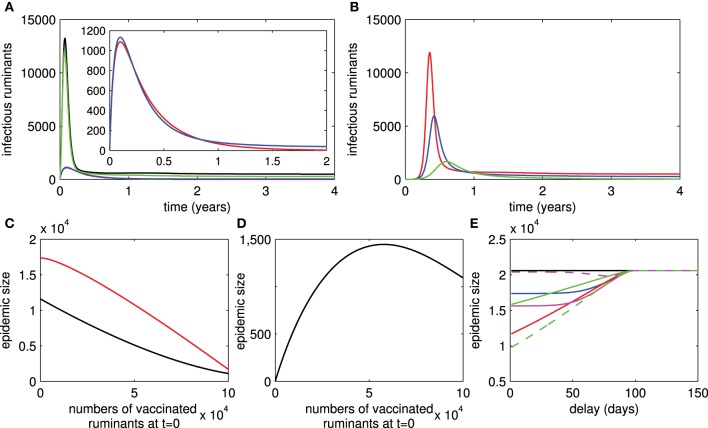
Live and killed vaccines. Infectious numbers of ruminants over time in case of live vaccines are shown in (A) (black trace = with no vaccination and R0 > 1, green trace = with vaccination and R0 > 1, blue trace = with vaccination and R0 < 1, red trace = with no vaccination and R0 < 1). Infectious numbers in case of killed vaccines are shown in (B) (red trace = with no vaccination and R0k>1, blue trace = with vaccination and R0k>1, green trace = with vaccination and R0k<1). (C) Shows that the epidemic size of an outbreak decreases when the number of vaccinated ruminants at t = 0 increases and R0 > 1 for both live and killed vaccines (red trace = live vaccines, black trace = killed vaccines). The epidemic size of an outbreak when the number of vaccinated ruminants at t = 0 varies and R0 < 1 for live vaccines is shown in (D). (E) Shows the epidemic size of an outbreak corresponding to the delays in vaccination after an infectious ruminant is introduced for live and killed vaccines (red and solid traces: ρ11 = 0.8, ρ12 = 1, ρ13 = 0, δ = 0.9, magenta and solid traces: ρ11 = 0.8, ρ12 = 0.9, ρ13 = 0.05, δ = 0.8, magenta and dashed traces: ρ11 = 0.8, ρ12 = 0.8, ρ13 = 0.05, δ = 0.8, green and dashed traces: ρ21 = 0.8, ρ22 = 0.8, σ = 0.8, blue and solid traces: ρ21 = 0.8, ρ22 = 0.8, σ = 0.8, green and solid traces: ρ21 = 0.8, ρ22 = 1, σ = 0.9).